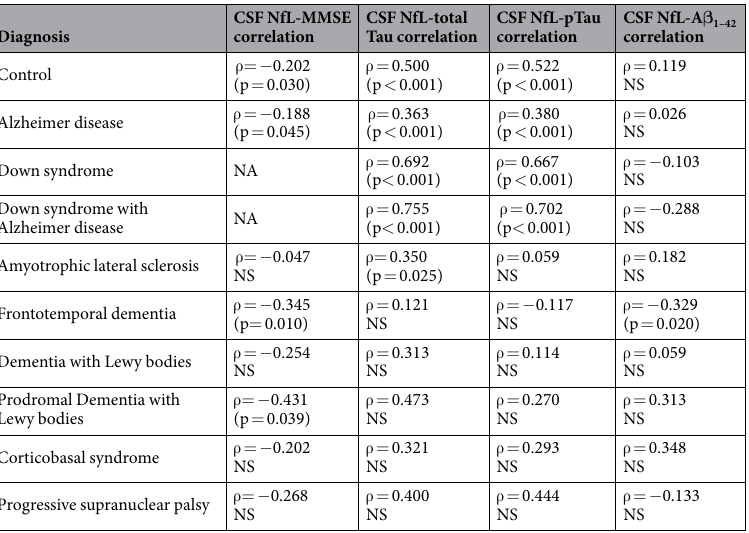
Table 2. Correlation between CSF NfL and MMSE or core biomarkers among the clinical groups. Abbreviations: MMSE: Mini-Mental state examination, NS: not statistically significant, NA: Not Applicable, NfL: Neurofilament Light.